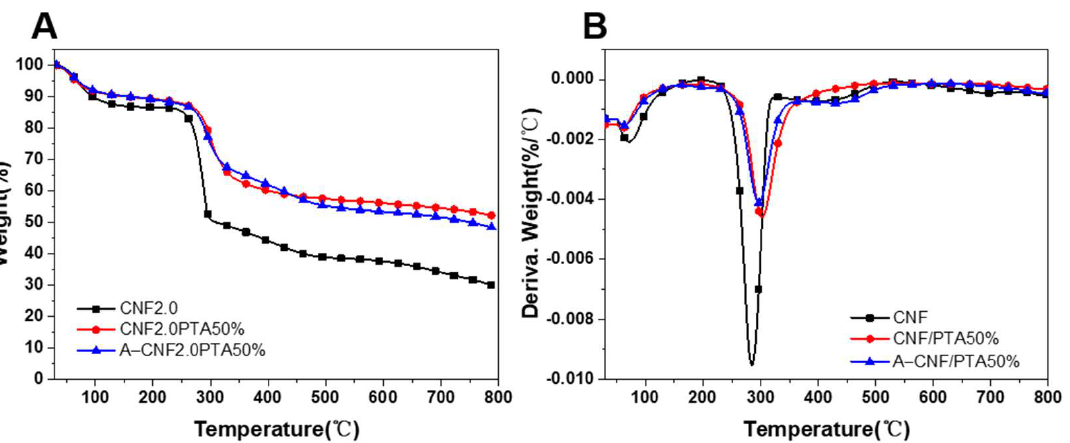
Figure 6. Thermogravimetric analysis ( A ) and derivative thermogravimetric analysis ( B ) curves of the CNF aerogels.